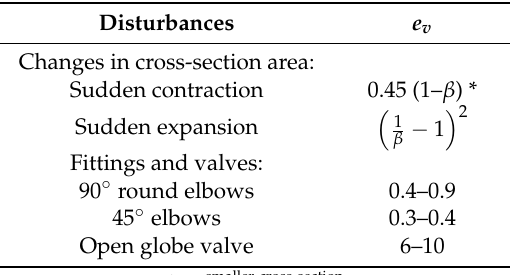
Table 2. Common values for friction loss factors